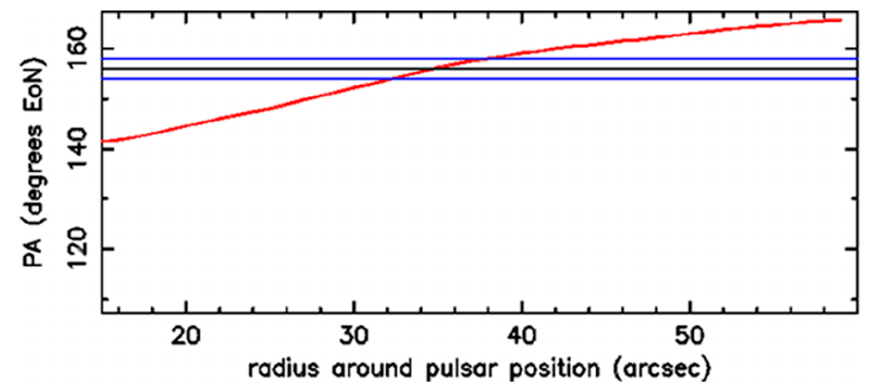
Figure 6. Comparison of the position angle as measured in the optical with the OSO-8 result. The red line is the optical polarization. The black line is the OSO-8 result with errors shown in blue.